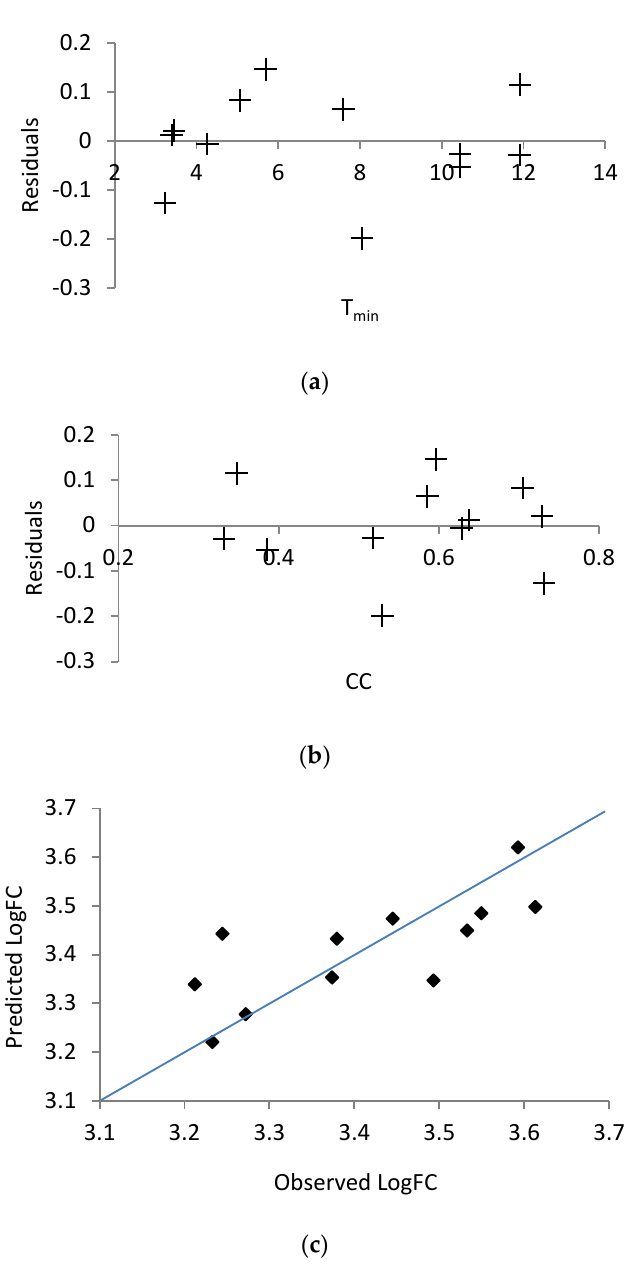
Figure 8. Residuals as a function of ( a ) T min , and ( b ) CC , and ( c ) trend of predicted versus observed Log FC m with one to one line shown in blue.